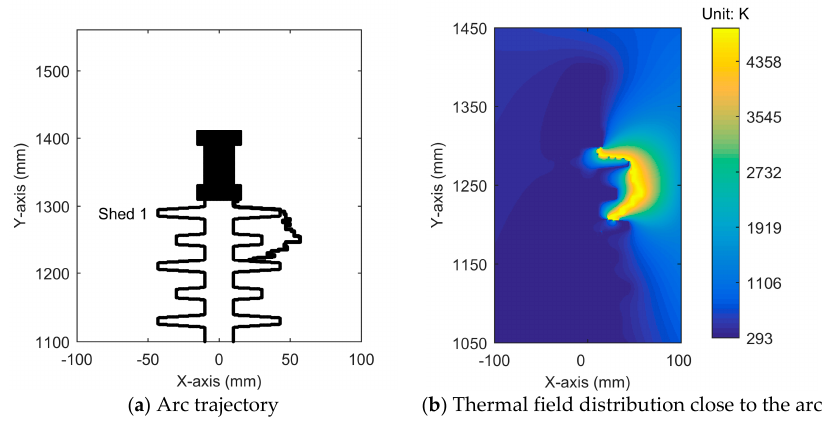
Figure 7. Arc trajectory and thermal field distributions close to the HV electrode when the first arc ignites.